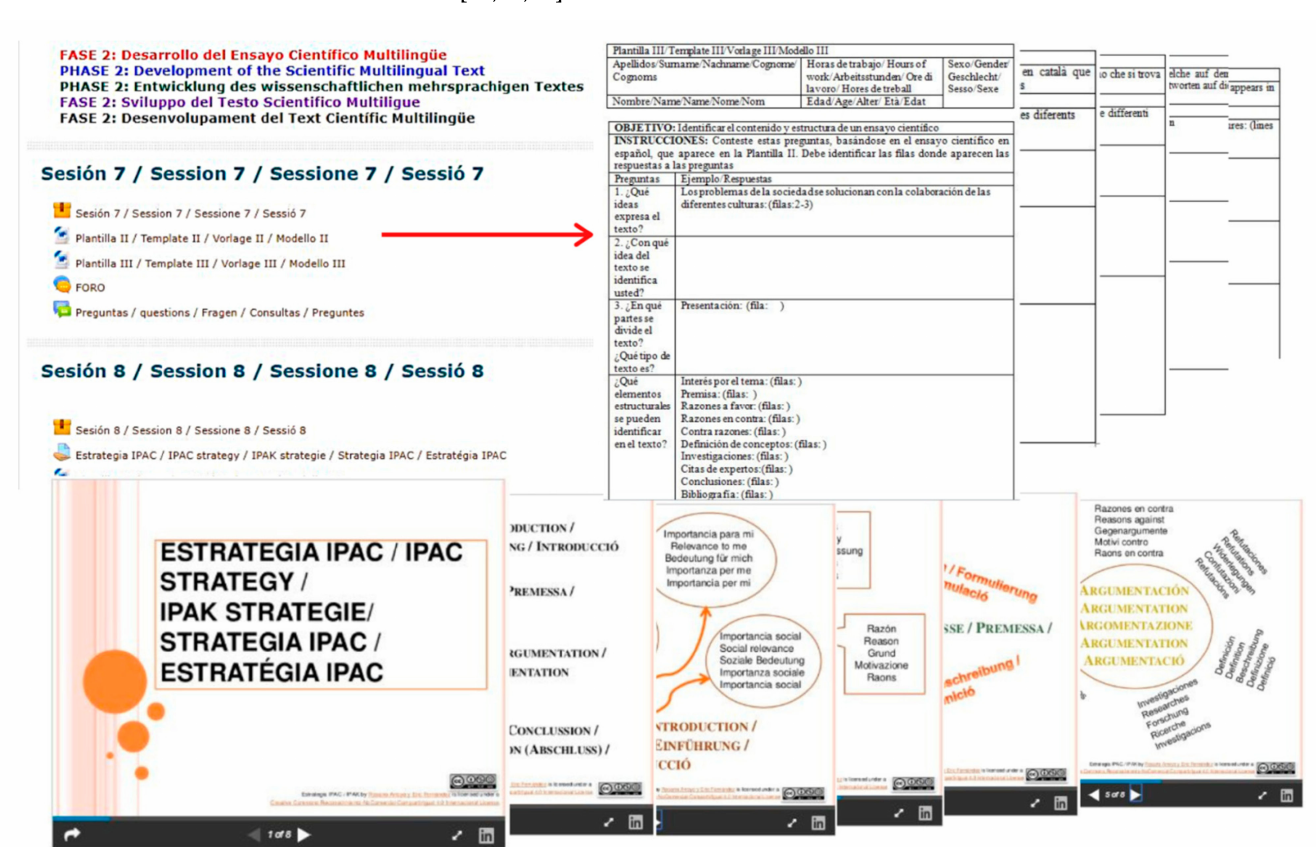
Figure 1. Phase 2 Interface, Sessions 7 and